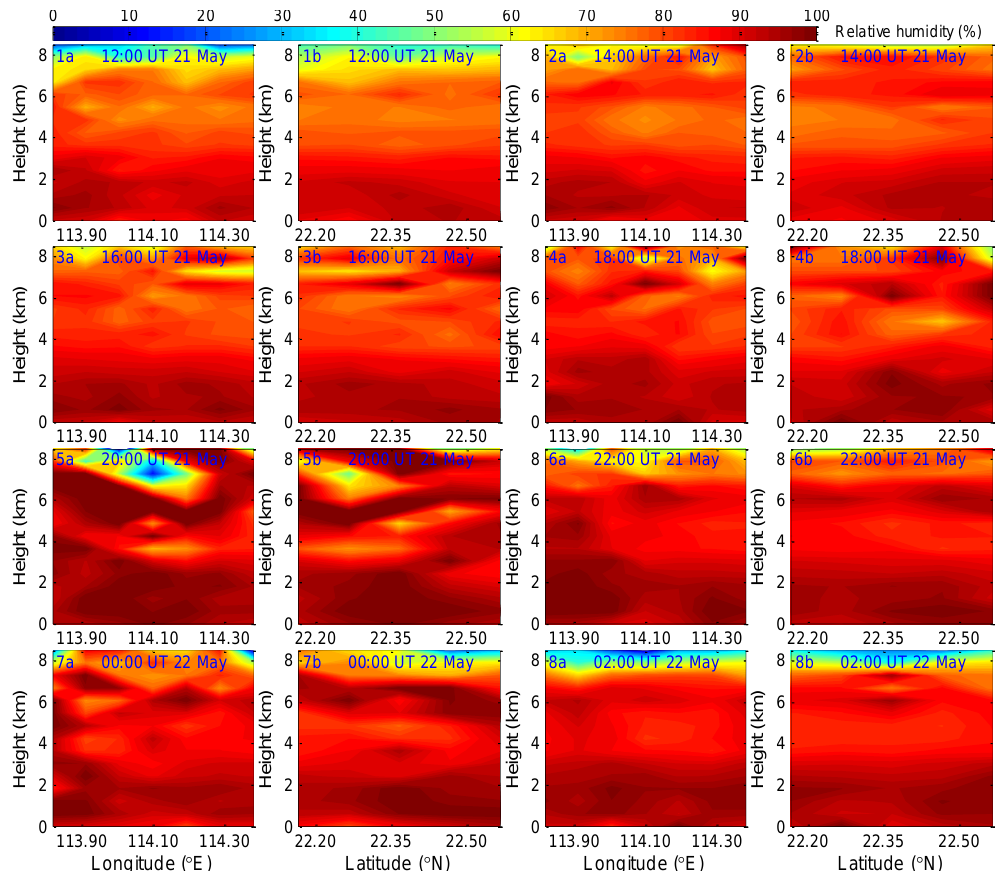
Figure 8. Evolution of tomographic relative humidity profiles every 2h from 21 May 12:00UT to 22 May 2013 02:00UT. Subgraphs tagged with “a” refer to the relative humidity sections along the longitude of 114.17 ◦ E. Subgraphs tagged with “b” refer to the relative humidity sections along the latitude of 22.30 ◦ N. The longitude 114.17 ◦ E and latitude 22.30 ◦ N specify the location of the HKO weather